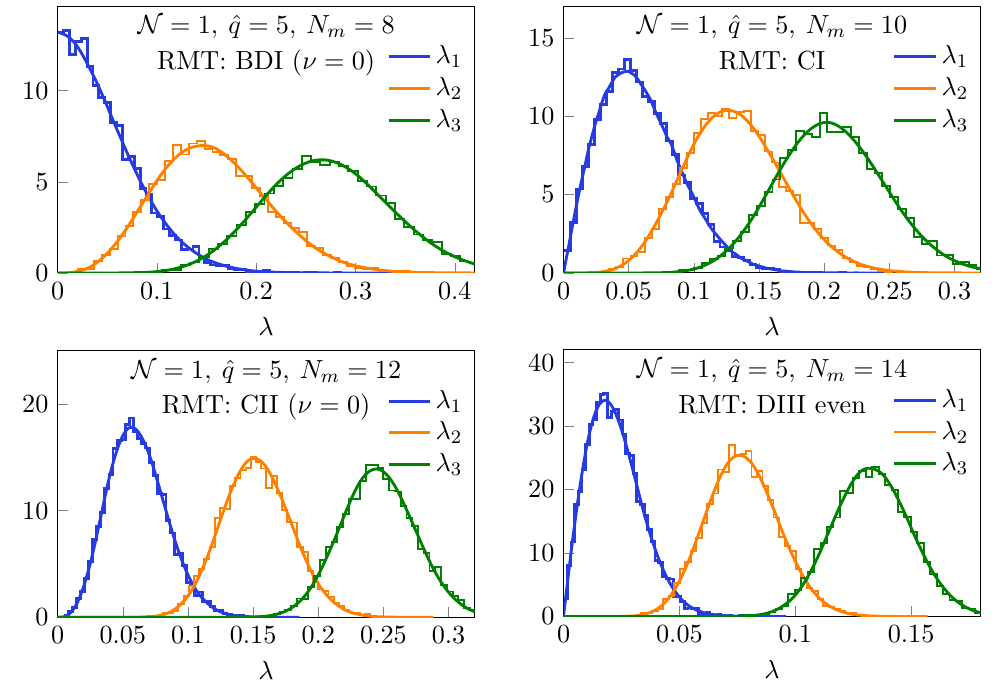
Figure 5 . Same as (cid:12)gure 4 but for ^ q = 5 and compared with the RMT predictions in table